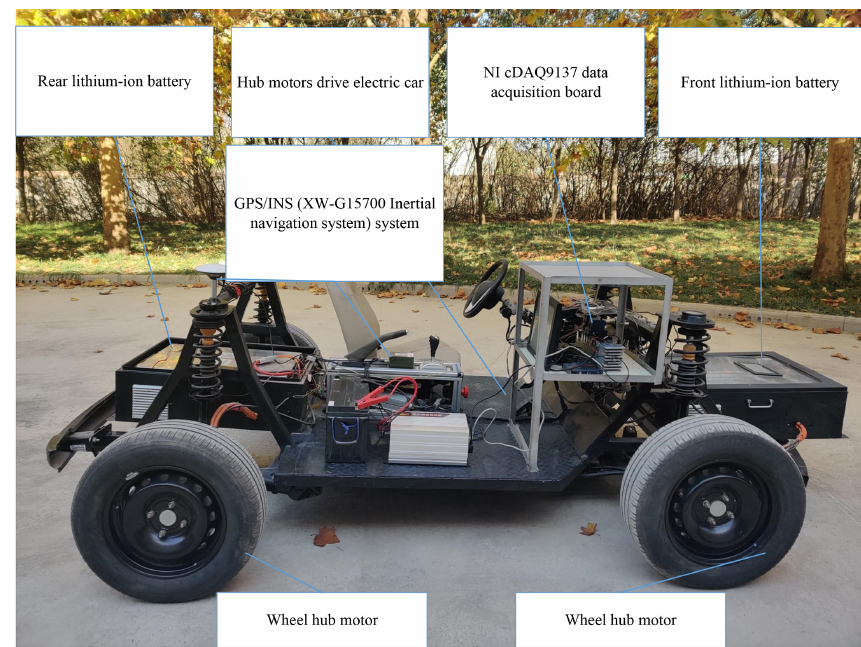
Figure 9. The hub-motor experimental